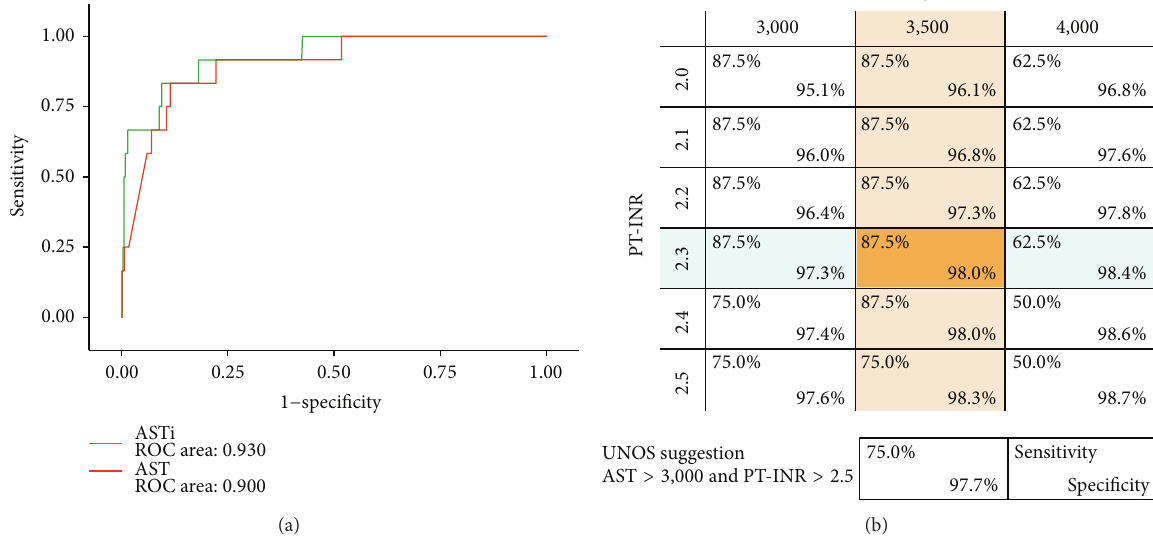
Figure 2: Prediction of PNF by AST and ASTi. Receiver-operating-characteristic (ROC) curves for AST and adjusted AST (ASTi) at risk for primary nonfunction of graft (PNF) show the relationship between true positive and false positive rates for a test across various threshold values used to diagnose a condition. The area under the curve (C statistic) for the ROC shown in ASTi is 0.930. The C statistic for AST in the same cohort was 0.900. ASTi is better predicting posttransplant PNF. UNOS criteria of PNF had sensitivity of 75% and specificity of 97.7% in our cohort of study population. Combination of ASTi ≥ 3,500 IU/L and PT-INR ≥ 2.3 had the best predictive value of sensitivity 87.5% and specificity of 98.0%, which is better than UNOS criteria.